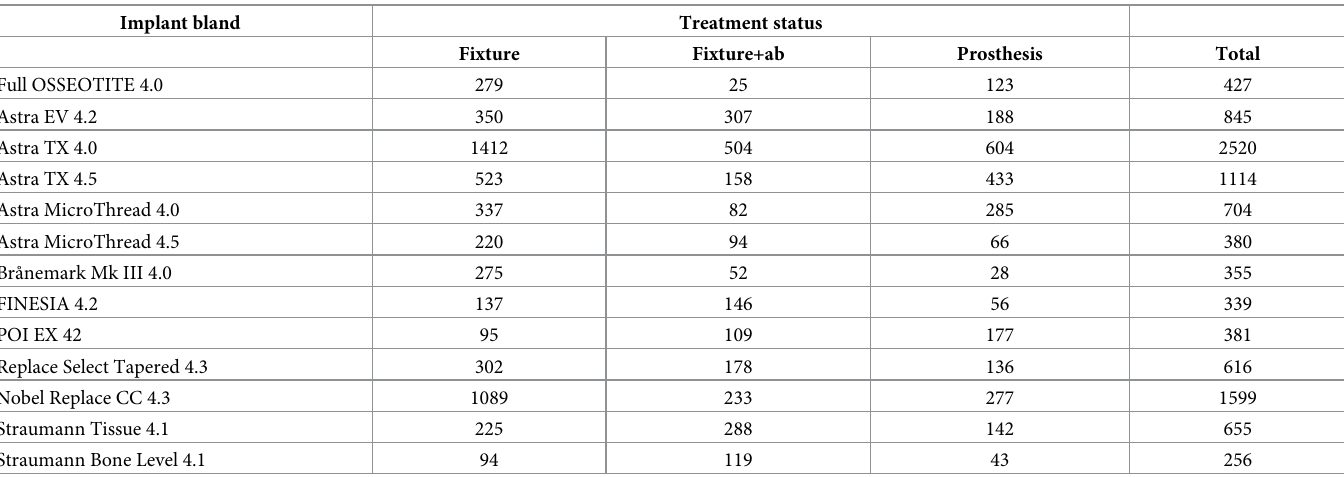
Table 2. Distribution of implant brands used in the study.